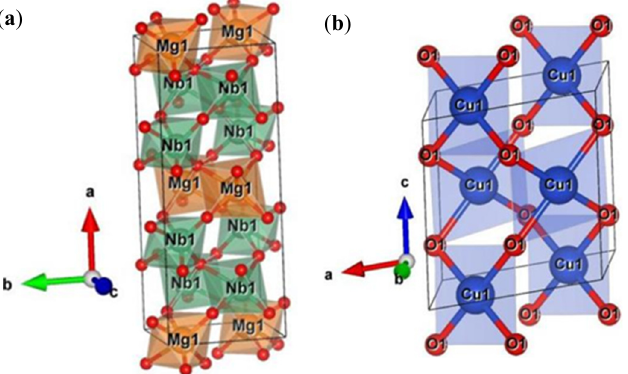
Figure 2. The crystal structures of ( a ) orthorhombic columbite MgNb 2 O 6 and ( b ) monoclinic CuO. Table 1. Crystal structure information of the MgNb 2 O 6 (p1) and CuO (p2) after refinement.